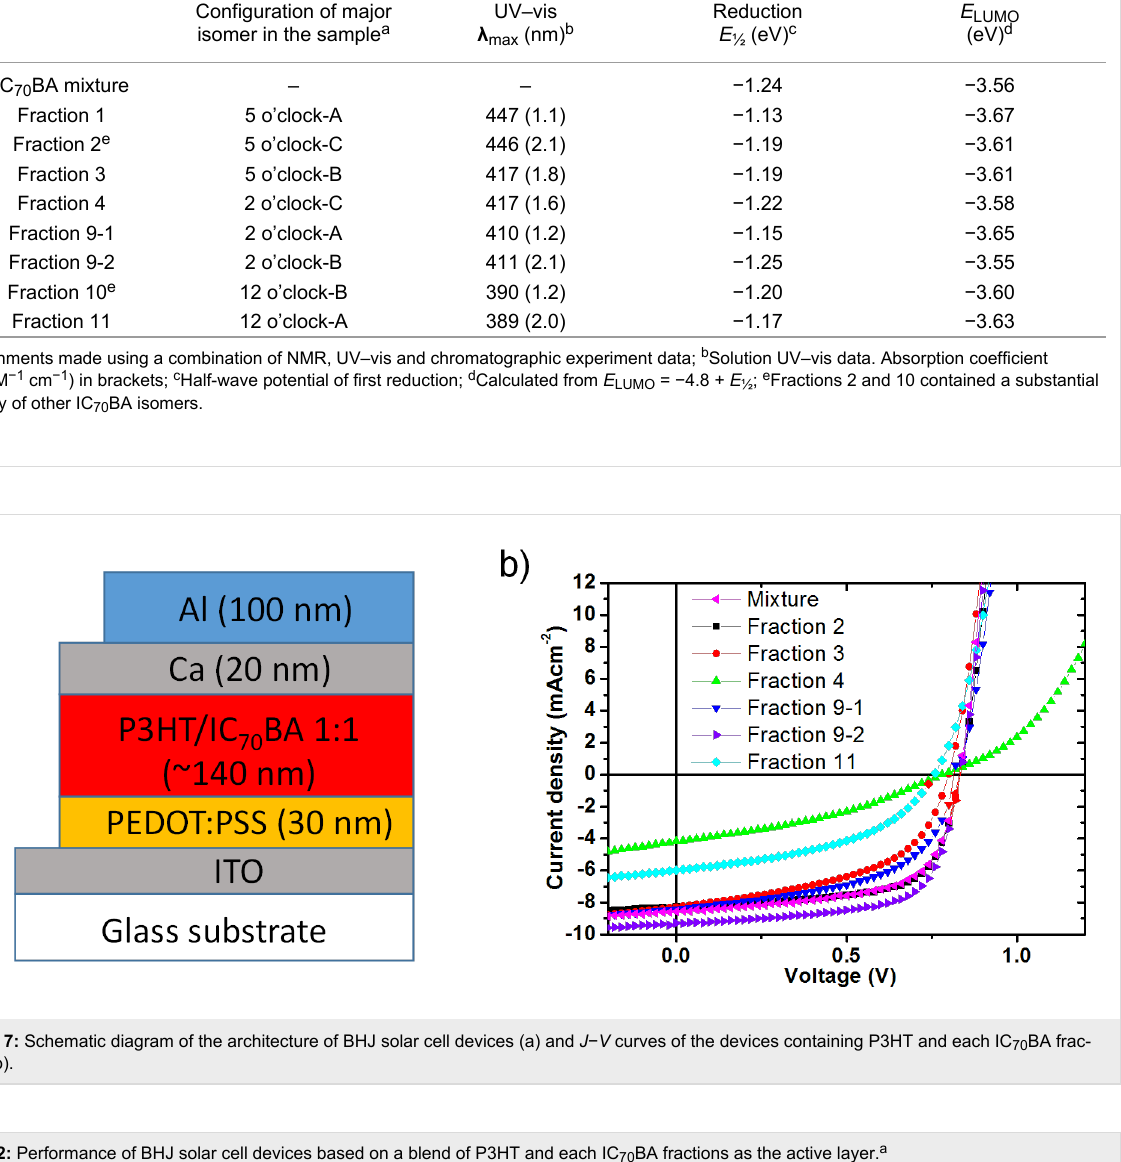
Active layer P3HT/IC 70 BA